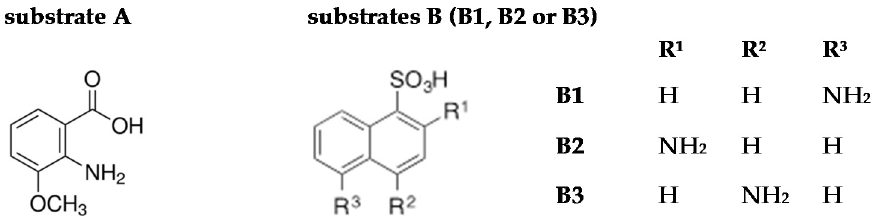
Figure 1. Structure of substrates used for laccase (LAC)-mediated heteromolecular transformations. R—the designation of specific substituents hydrogen atom (H) or amine group (NH 2 ) in individual places.